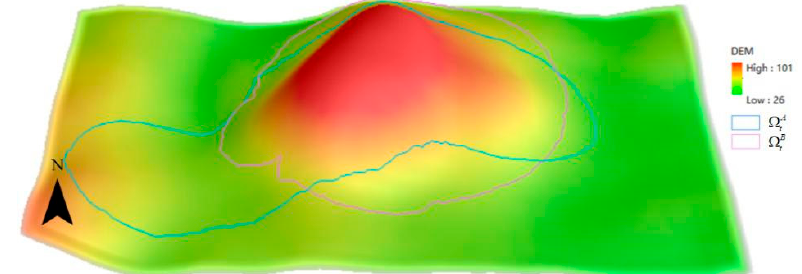
Figure 7. The reachable ranges Ω A